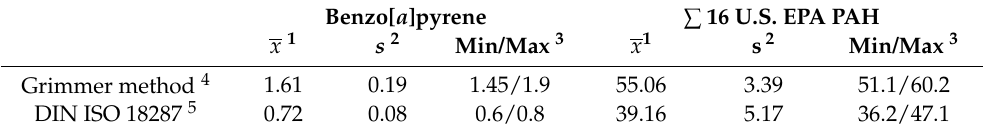
Table 5. Comparison of PAH content for different methods and identical material ( n =